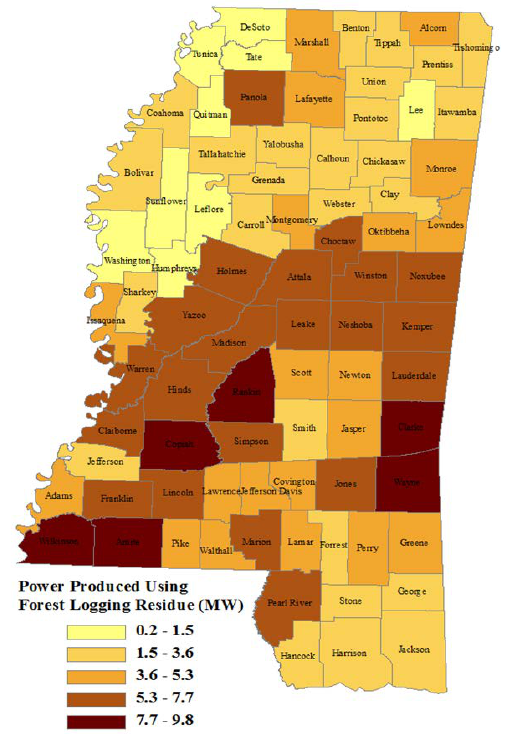
Figure 4. County-level potential CHP capacities (MW) for Mississippi based on 30% utilization of forest logging